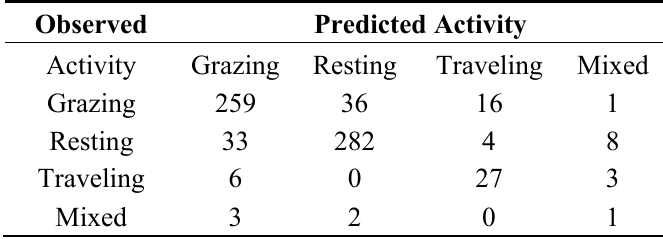
Table 3. Frequency of observed vs. predicted cattle activities based on the selected 10-split categorical classification tree model (Figure 3) applied to the validation